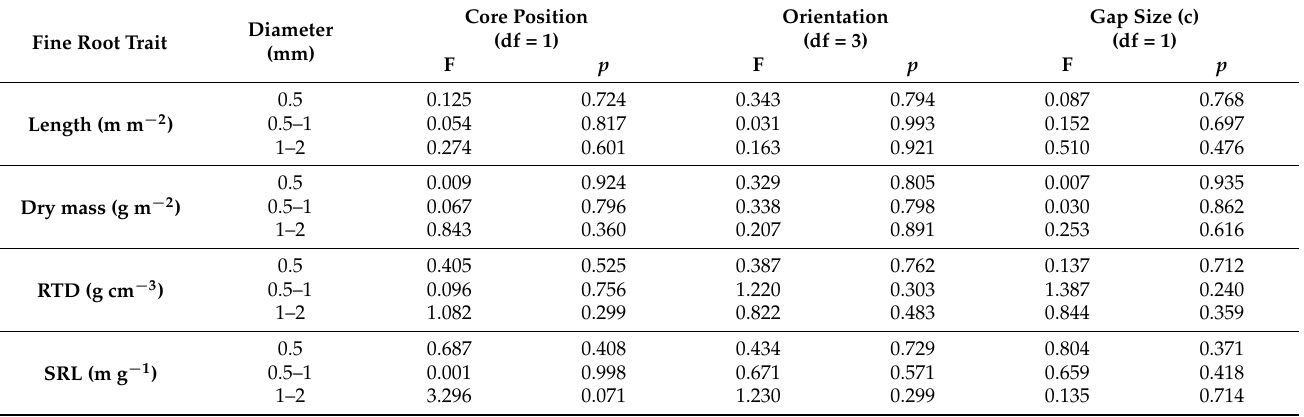
Table 1. F and p values of ANCOVA (General Linear Model) for the effects of core position and orientation on morphological fine root traits divided by diameter classes. Gap sizes were used as covariates. Interactions were not significant and therefore excluded from the